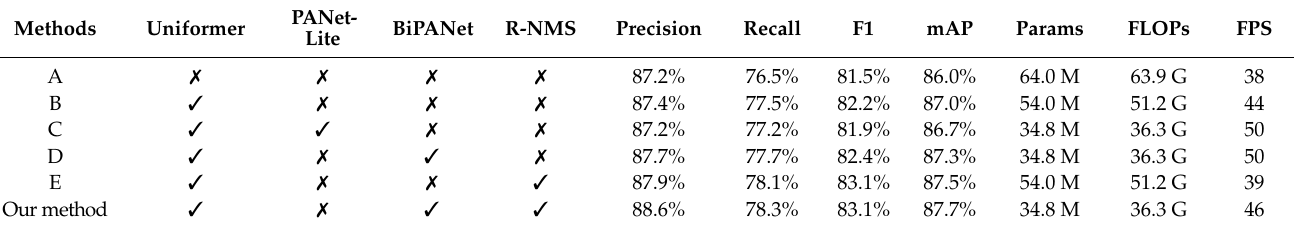
Table 5. Experimental results of different methods on the WGISD.